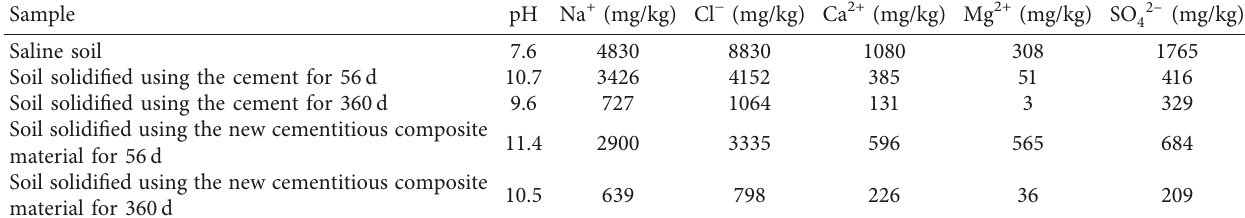
Figure 5: Long-term strengths of saline soil solidified by using the new cementitious composite materials and cement. (a) Standard curing. (b) Curing in fresh water. Table 8: Water-soluble salt ion contents and pH.